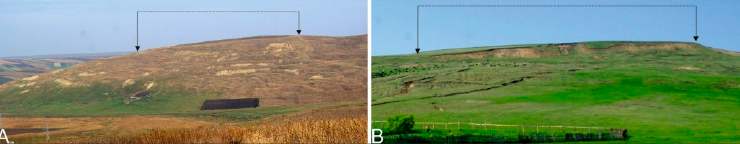
Figure 2. Eastward ( A ) and Westward ( B ) views of the Dealul Mare/Dealul Boghiu archaeological site (photo: Nicu, C.).